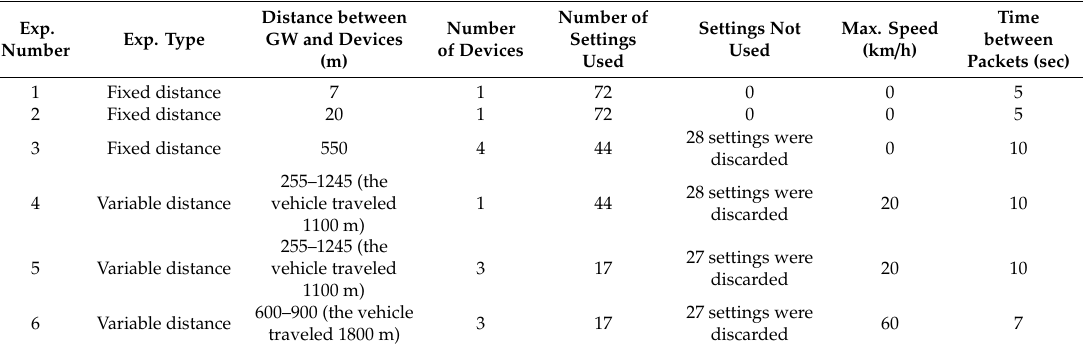
Table 1. Characteristics of the performed